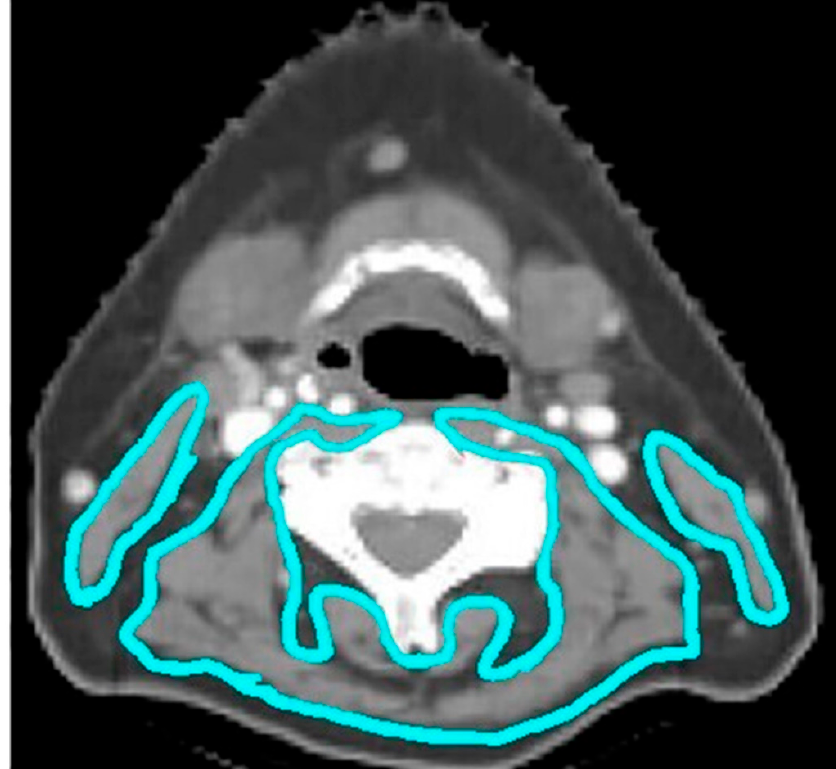
Figure 1. A representative case example of a 54-year-old man with an HPV-positive oropharynx cancer. A single axial CT slice is taken at the C3 vertebral body level with contours of the sternoclei- domastoid and paravertebral muscles delineated in turquoise. Skeletal muscle was defined as − 29 to +150 Hounsfield Units (HUs), and the total cross-sectional area (CSA) was computed automatically within the contoured